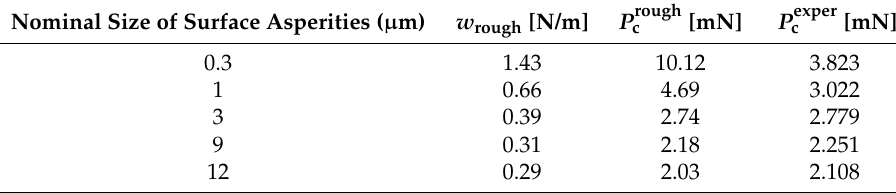
Table 2. The final outcomes of theoretical calculations in comparison with experimental results. Nominal Size of Surface Asperities ( µ